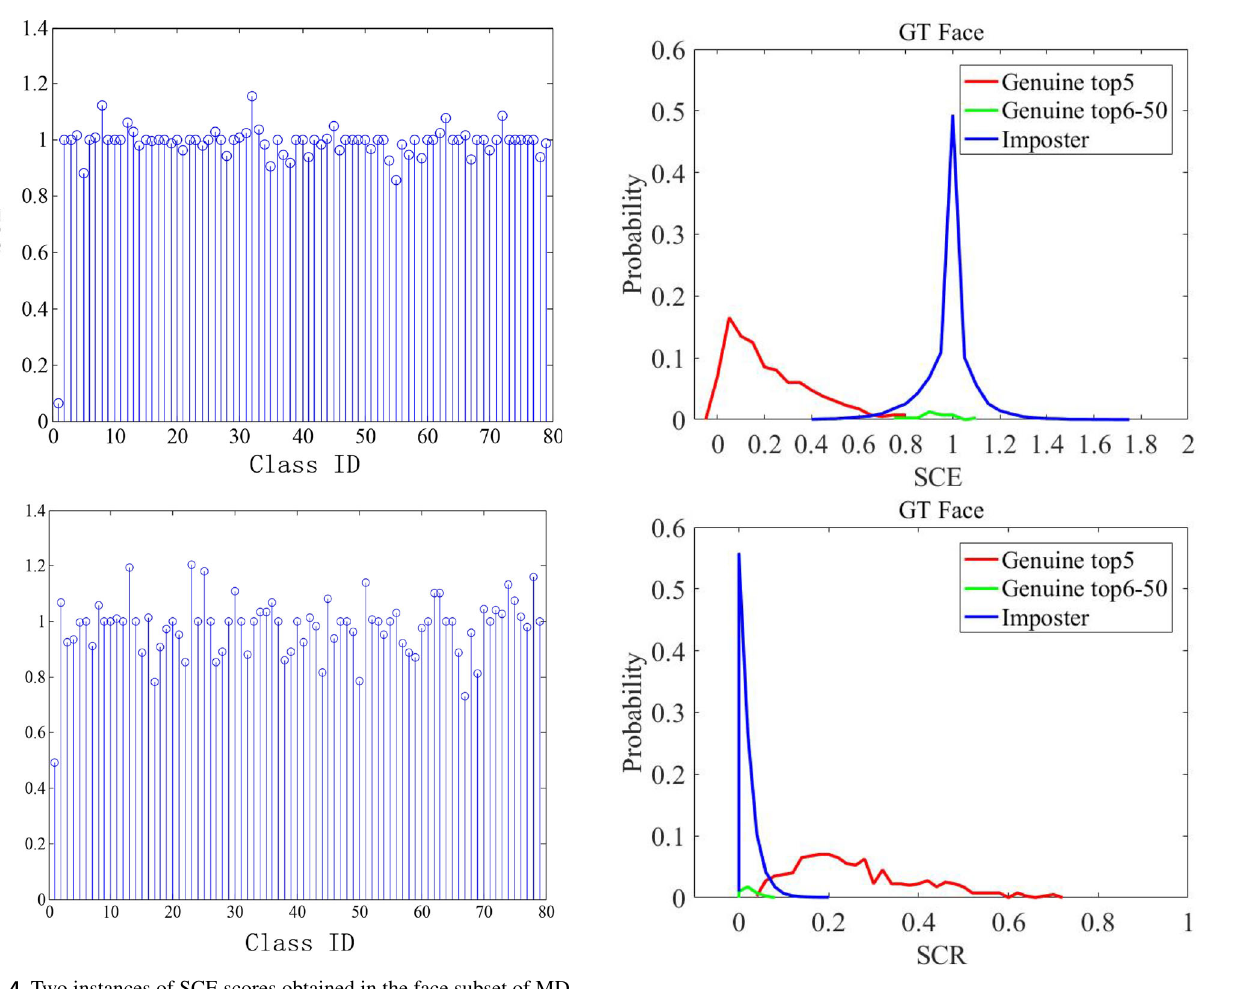
Fig. 5 Distributions of SCE and SCR scores on GT face dataset into two categories. The first category is the top 5 scores among all matching scores obtained in a verification